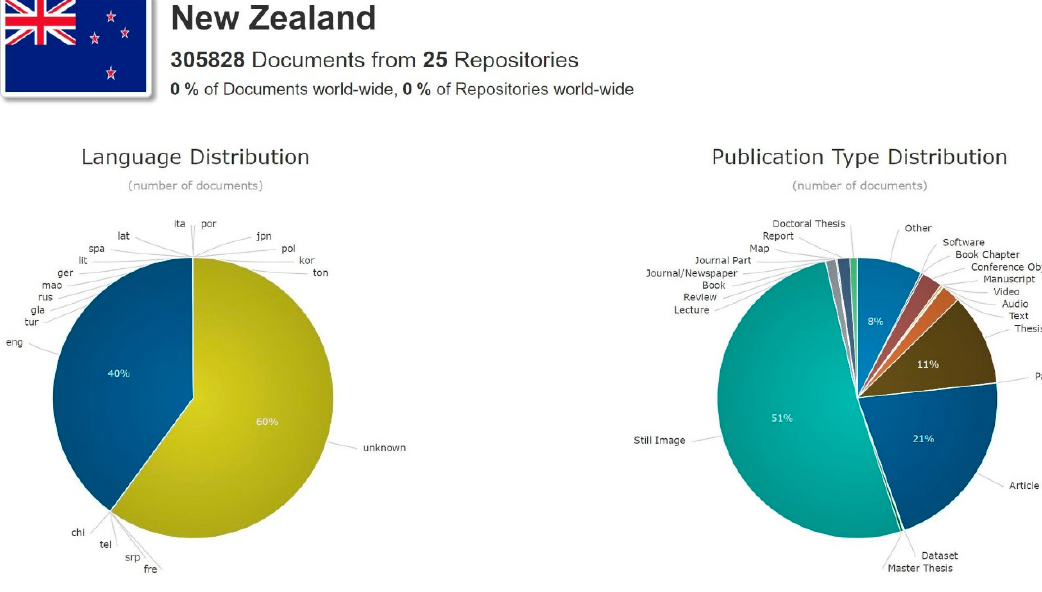
Figure 6. Timeline diagrams with the number of newly indexed repositories and the development of repositories and publications per year, in this case for Indonesia.